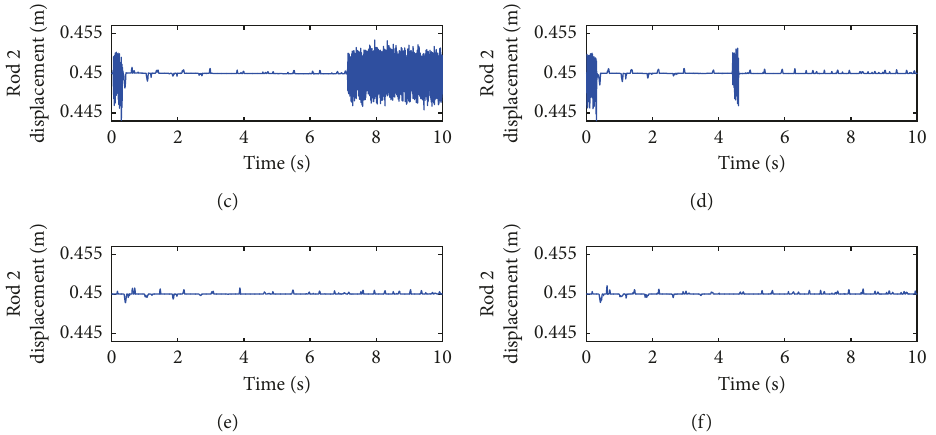
Figure 19: Displacement x 2 of rod 2 with different frictions f with c (d) f � 200N; (e) f � 250N; (f) f � 300N.